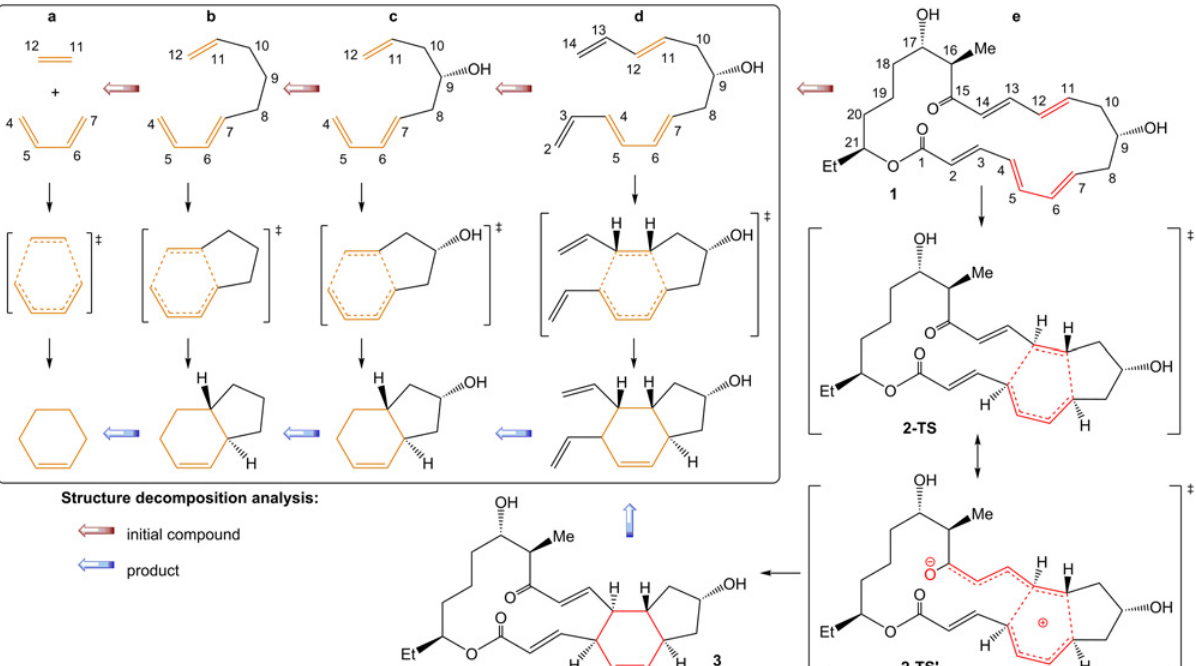
Fig 2. Structural decomposition analysis of the cycloaddition reaction. Structural decomposition analysis of the cycloaddition reaction involved in the biosynthesis of Spinosyn A into principal components (the atom numbering was the same as in compound 1 for comparative purpose).